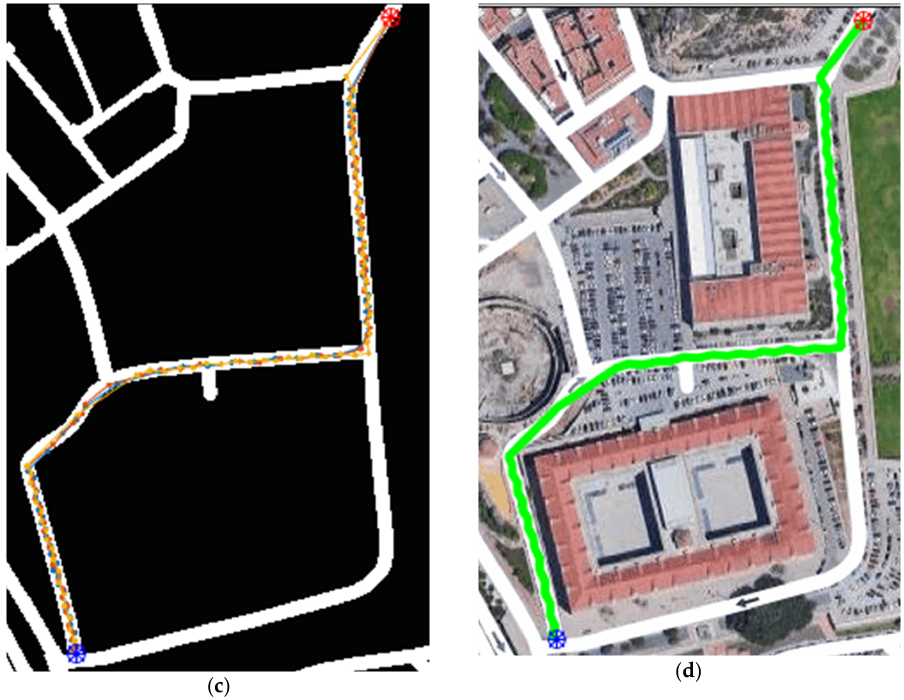
Figure 6. SCP applied on a real map. ( a ) Selection of the initial point on the real map; ( b ) cross points found on a binary map; ( c ) possible trajectories on a binary map; ( d ) optimum trajectory on the real map.